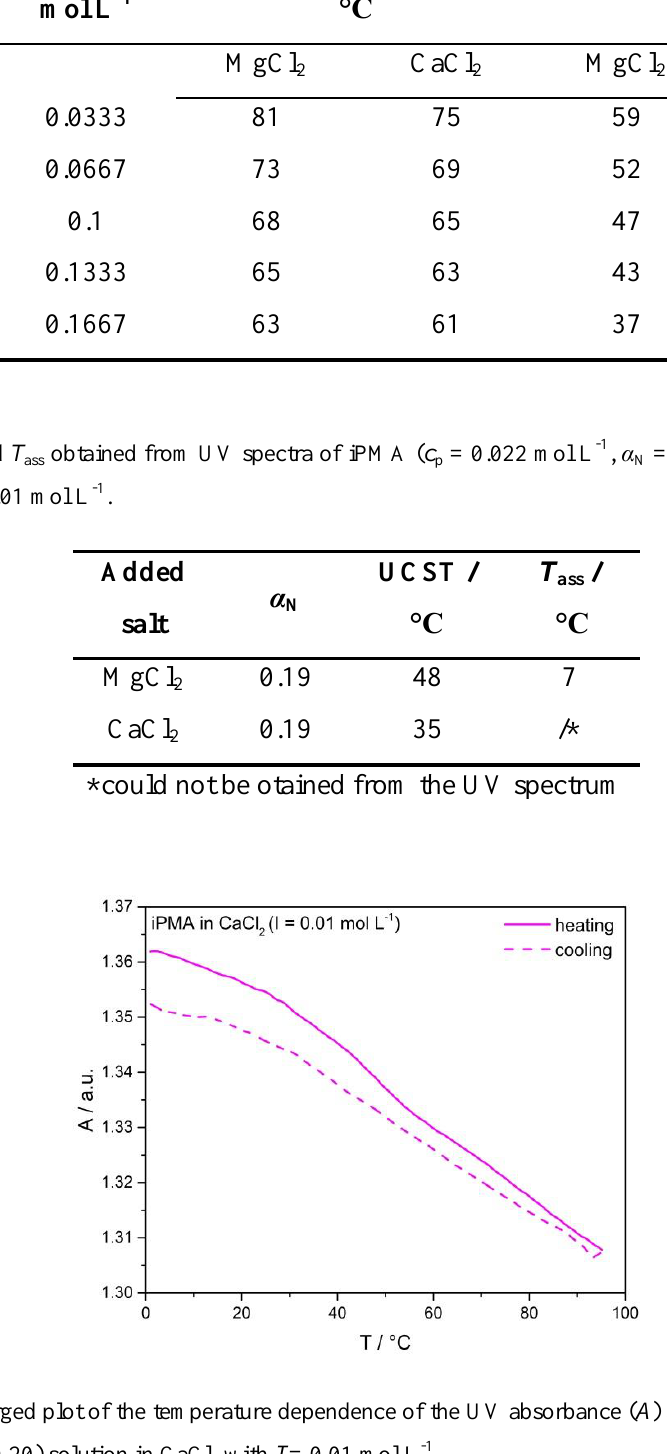
with I = 0.01 mol L -1 2